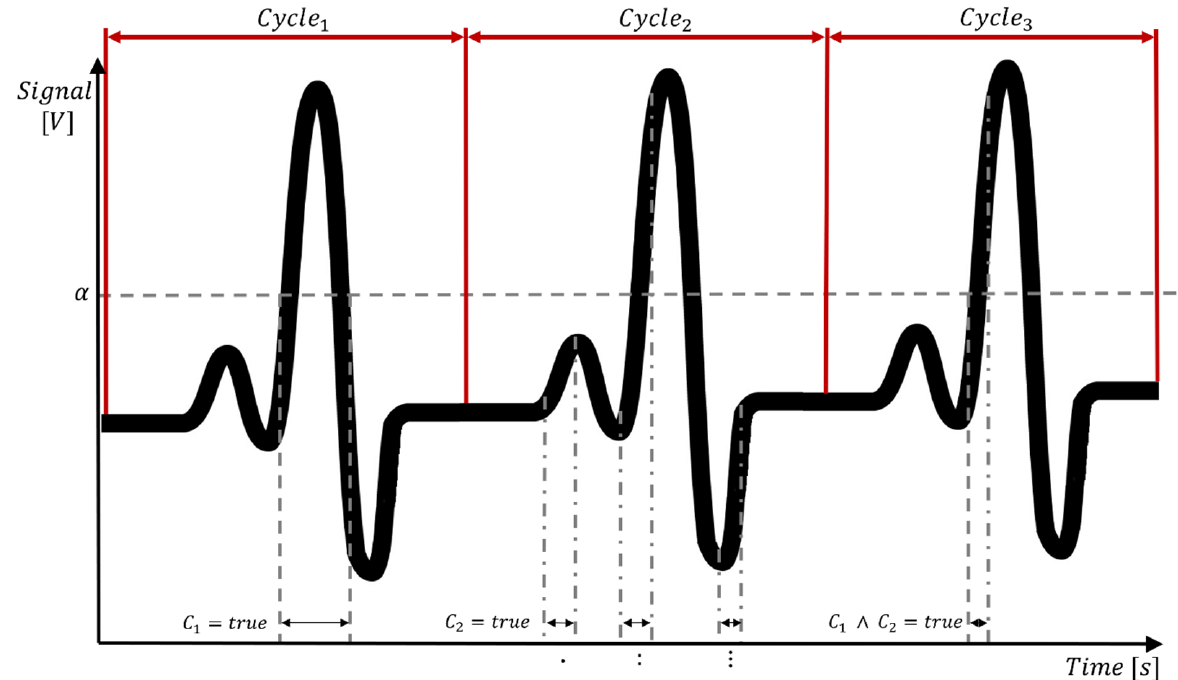
Figure 6. Schematic representation of pulse detection criteria.